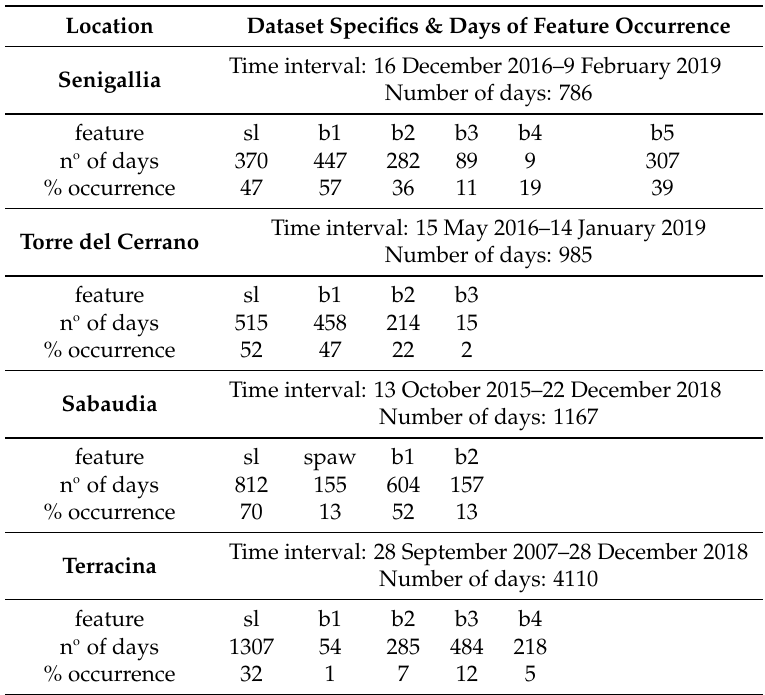
Table 2. The image datasets used for the study. For each location, the observational time intervals and the total number of observed days are reported. For each feature detected at a specific location, the number of days that the feature has been detected and its percentage of occurrence over the total number of days are also